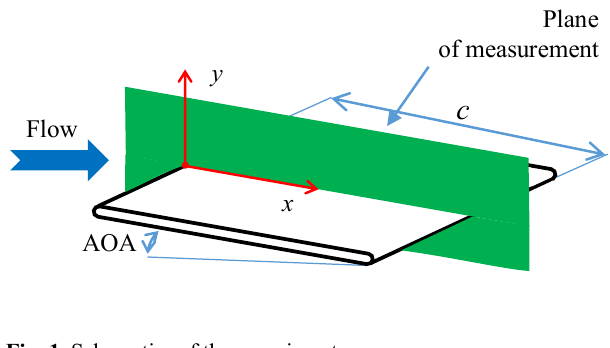
Fig. 1. Schematics of the experiment .